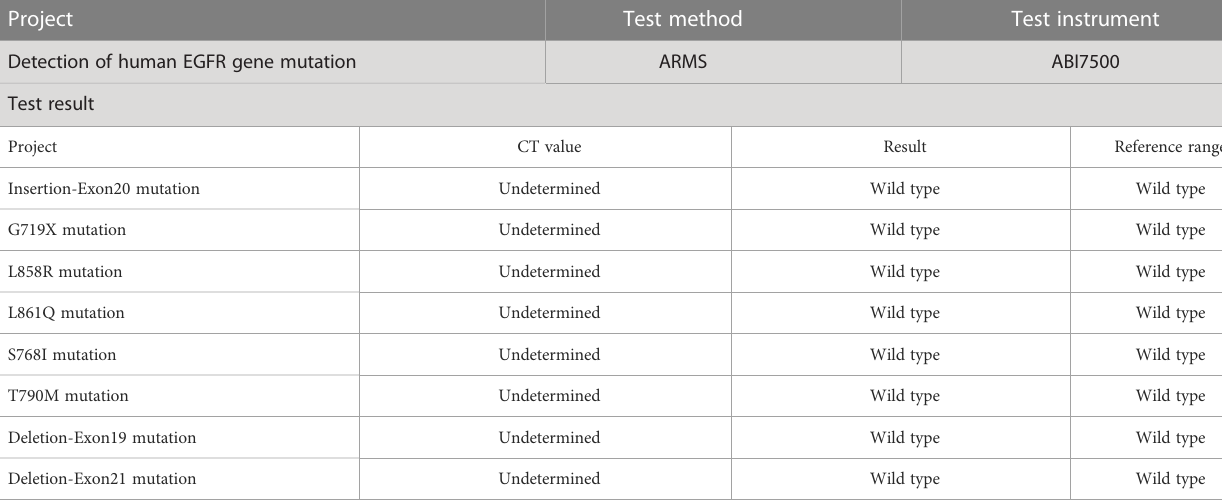
TABLE 1 Human EGFR mutation detection report from ShuWen Biology